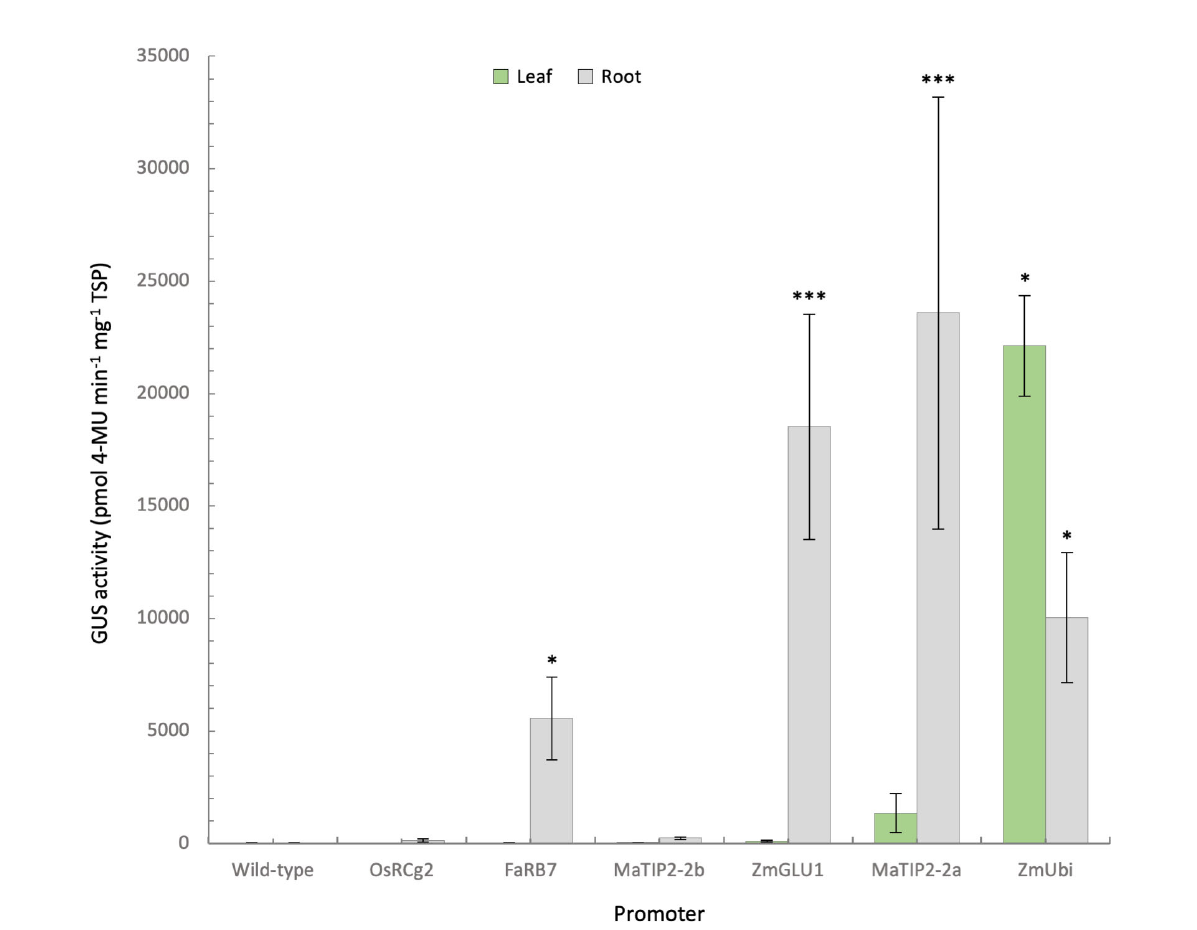
FIGURE 4 Quanti fi cation of GUS activity in leaf and root samples from promoter- uidA transgenic banana plants. GUS activity was measured in the leaves and roots of transgenic promoter- uidA banana plants and reported as mean r mol 4-methylumbelliferone (MU) min -1 mg -1 of total soluble protein (TSP) from 8 biological replicates assessed in triplicate except for wild-type (n=5) and Zea mays poly-ubiquitin (ZmUbi, n=3) plants. Non-parametric Kruskal-Wallis test and multiple comparisons with the Dunn ’ s Post-hoc test with p-values adjusted using the Benjamini- Hochberg method. Statistical difference with the wild-type asserted at *<0.05 and